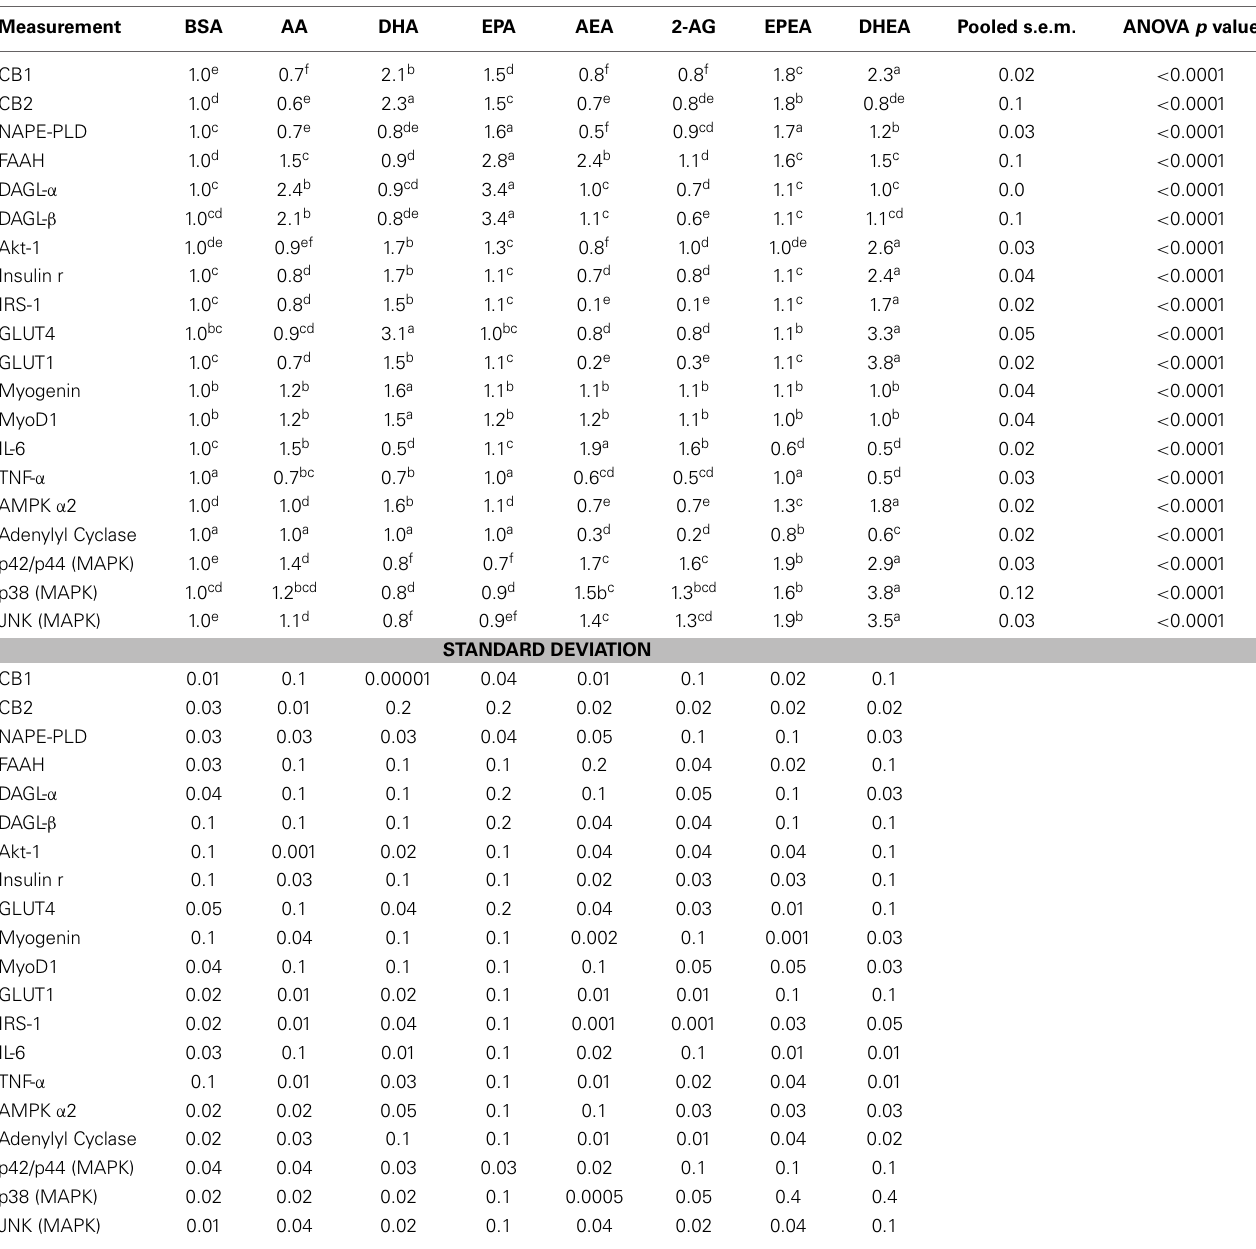
Data in the upper section of the table represent means of n = 3 for each cell culture group. qPCR output expressed in (cid:2)(cid:2) Ct normalized to BSA control. Values within rows having different superscripts are significantly different by One-Way ANOVA and Tukey’s mean separation test at α = 0.05. Values in the lower section of the table are the standard deviations of all